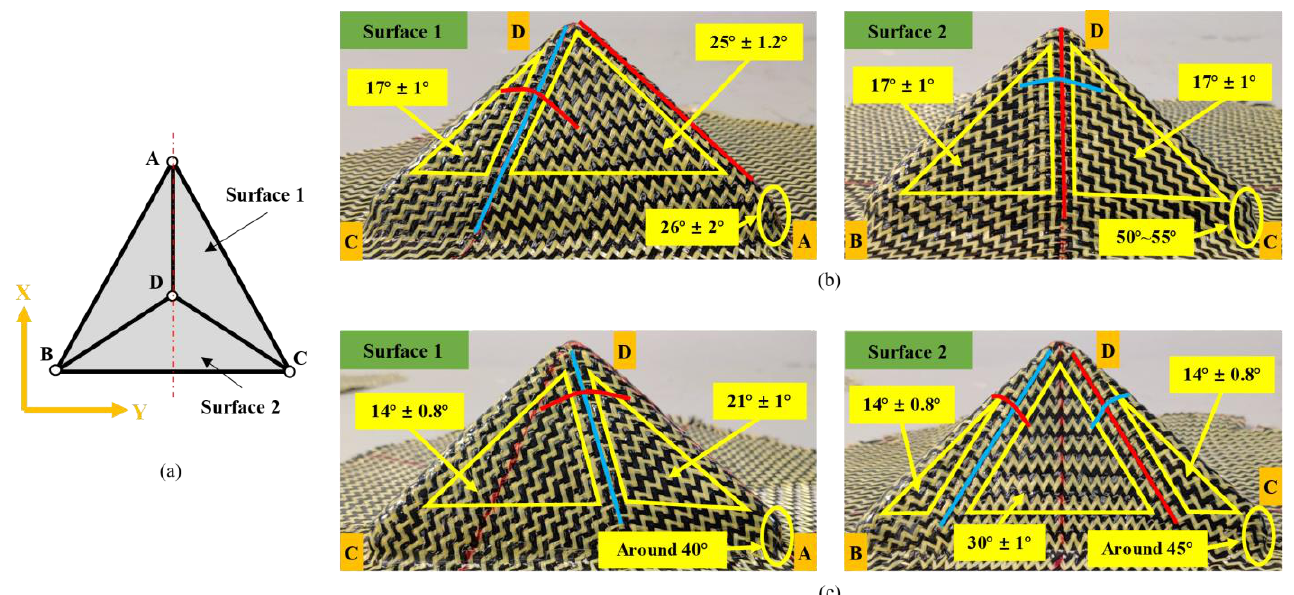
Figure 13. Shear angle distribution after tetrahedral preforming: ( a ) schematic diagram of tetrahedral preform description; ( b ) surface 1 (left) and surface 2 (right) of the tetrahedral preform with 0°/90° initial yarn orientation; ( c ) surface 1 (left) and surface 2 (right) of the tetrahedral preform with ±45° initial yarn orientation. Red lines for weft yarns; blue lines for warp yarns; yellow lines for shear zones.